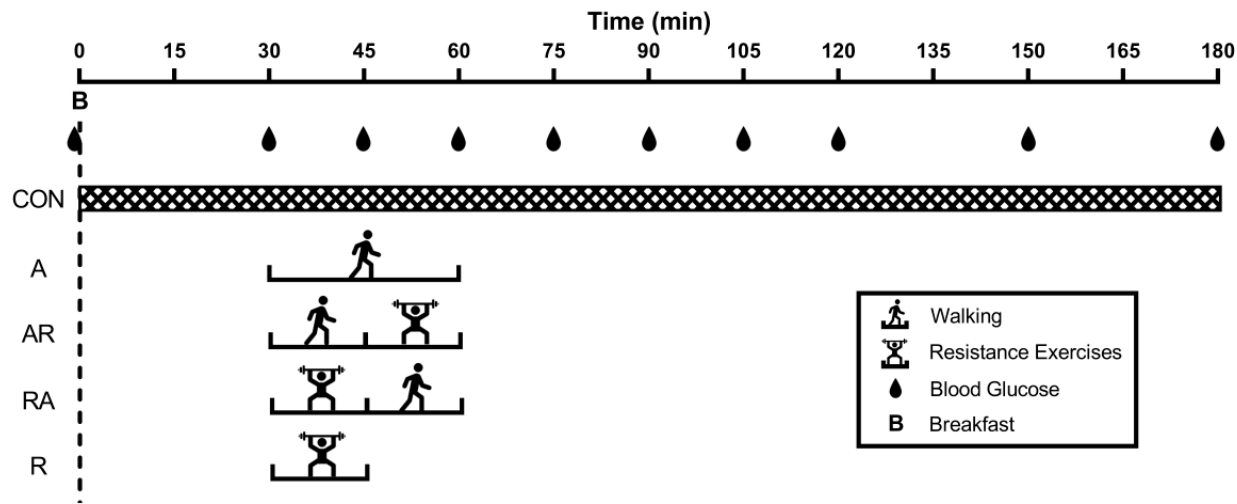
Figure 1. Graphic representation of the study design. Participants performed 30 min of walking (A), combined aerobic and resistance exercise (AR), combined resistance and aerobic exercise (RA), or 15 min of resistance exercise (R), starting 30 min after the beginning of the meal. A control (CON) condition was also performed.